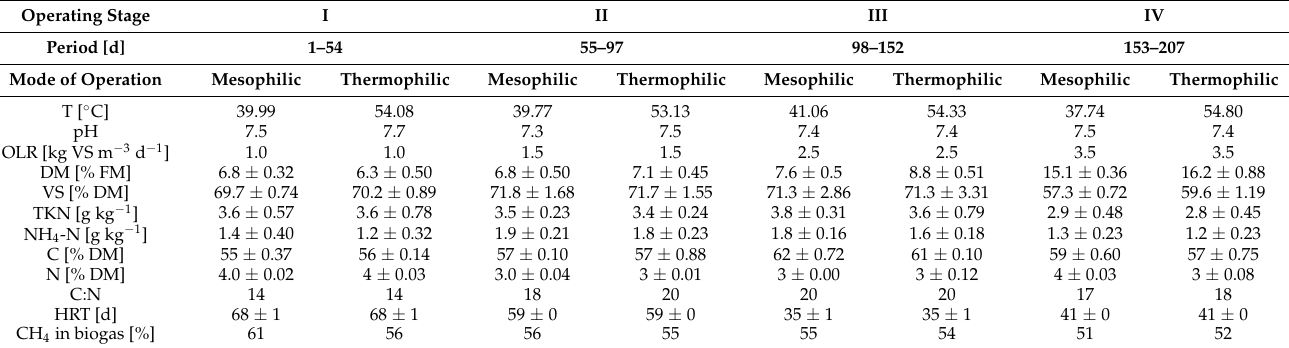
Table 3. Summary of the operating conditions of the reactors over the